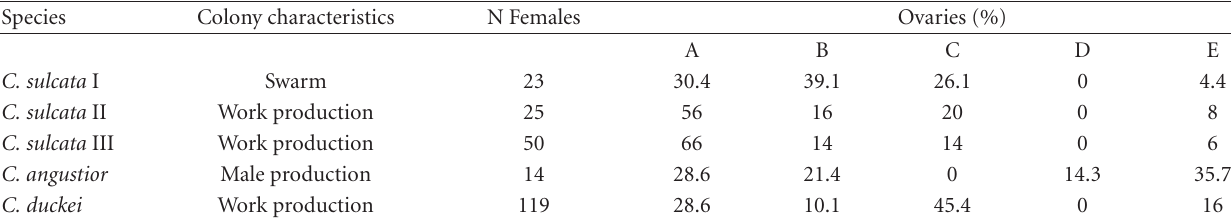
Table 1: Ovary development for all species analyzed in the genus Clypearia .